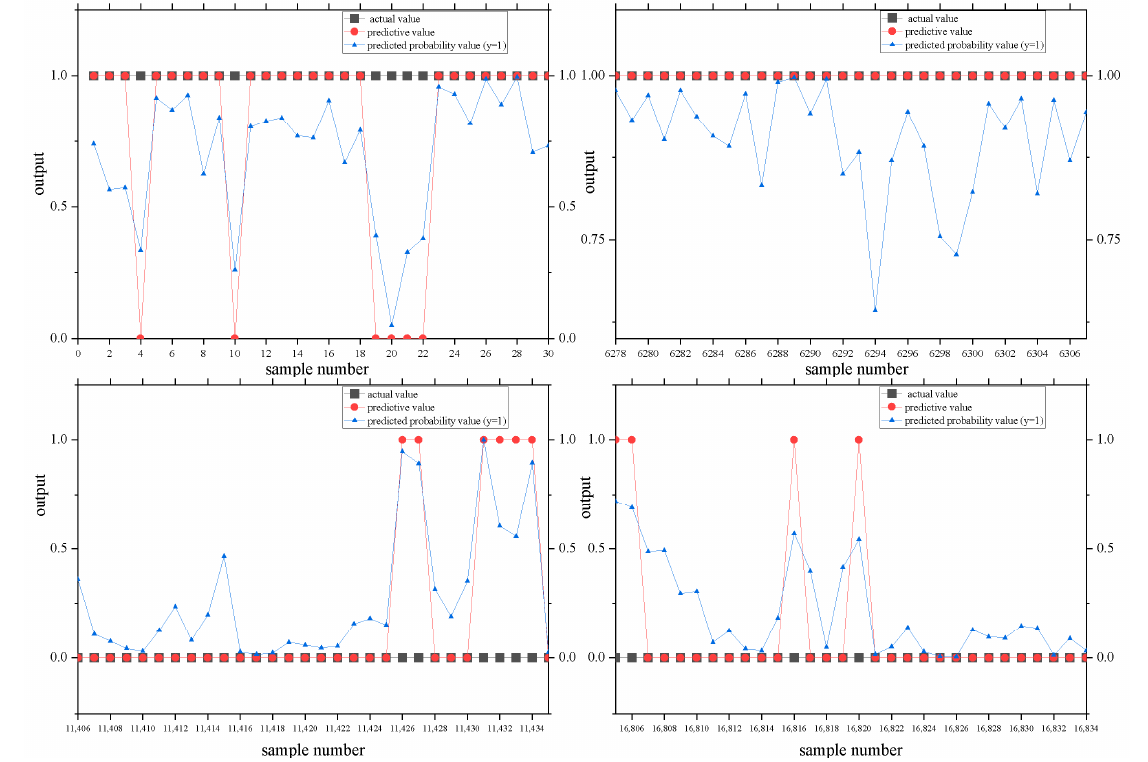
Figure 9. Comparison charts of the predictive and actual values of the RF (part of the sample).